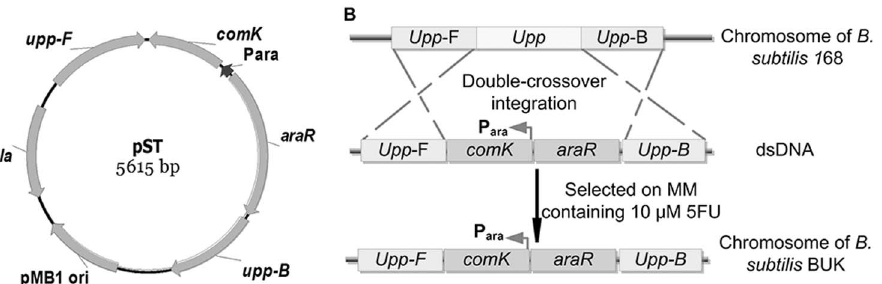
Figure 2. Construction of host strain B. subtilis BUK. (A) Two homologous arms of upp gene ( Upp -F and Upp -B) were cloned into pUC18, and the arabinose-inducible comK expression cassette was fused downstream of the front homologous arm to construct vector pST. (B) The sequence between two homologous arms of upp gene ( Upp -F and Upp -B), was replaced by comK cassette via a double-crossover recombination. Crossed lines indicated double-crossover recombinant events. Upp -F and Upp -B, upstream and downstream fragment of upp gene, respectively; comK , the master regulator ComK encoding gene for B. subtilis competence development; P ara , arabinose-inducible promoter of ara operon; araR , arabinose operon transcriptional repressor of B. subtilis